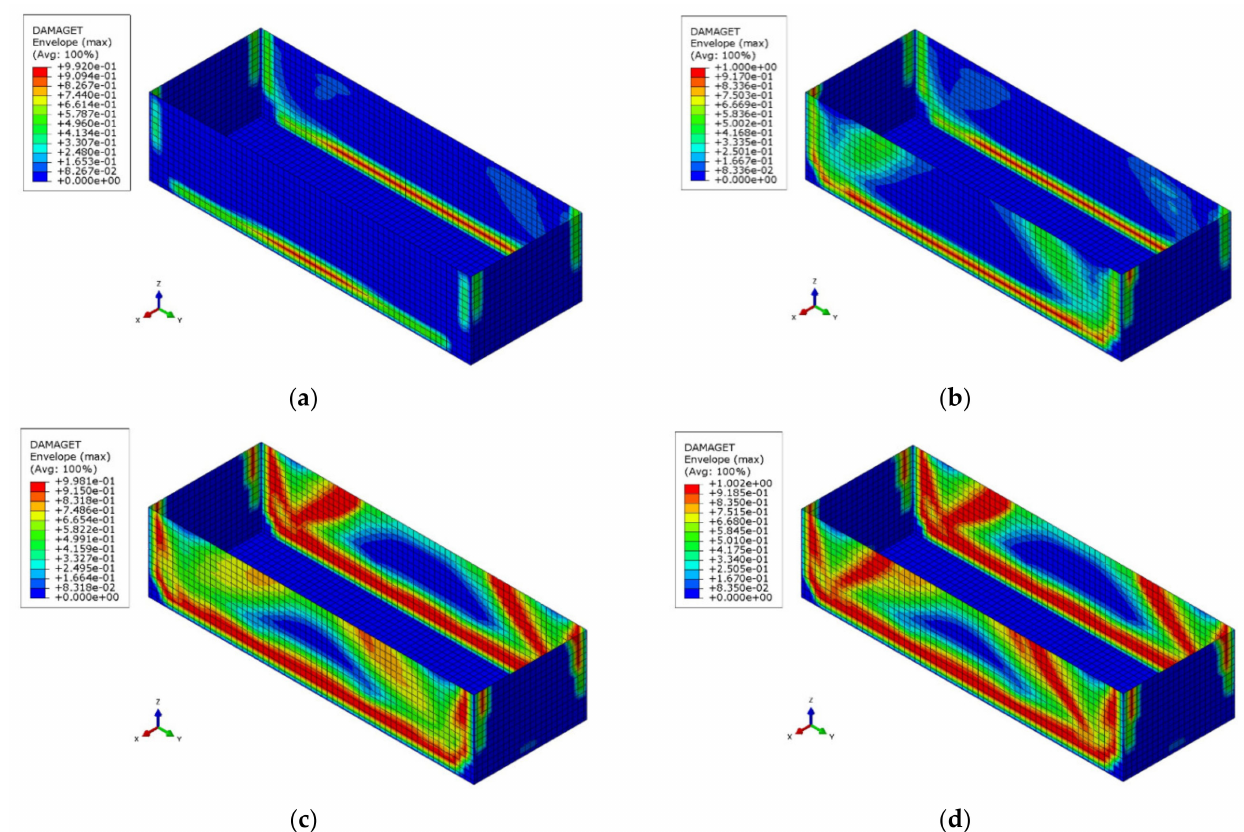
Figure 12. Tensile damage variable d t when the horizontal components of the input ground motion are considered only: